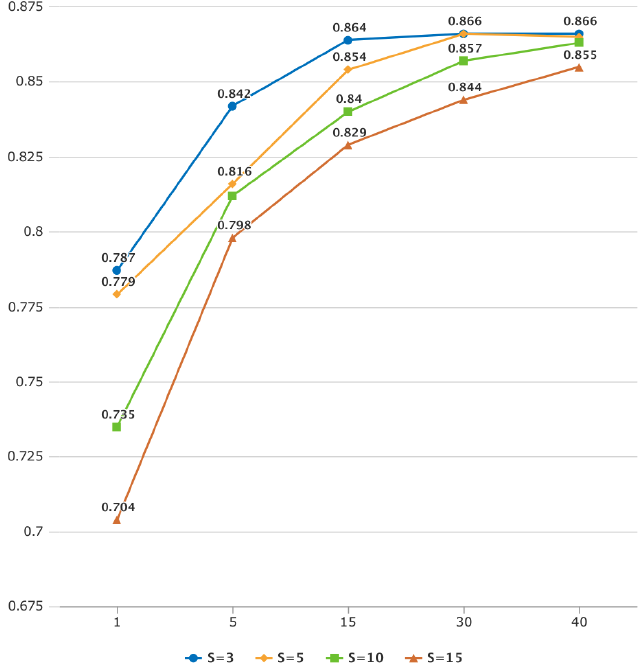
Figure 8. Change of Performance with Parameter s